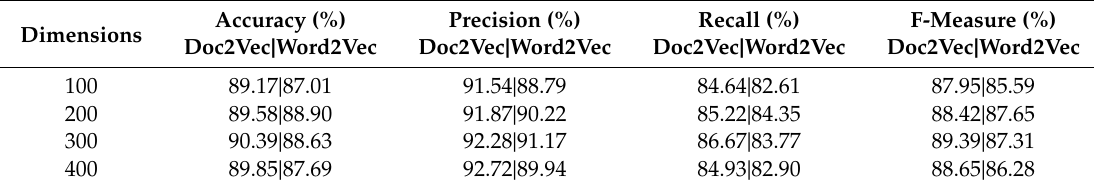
Table 5. Performance of Doc2Vec vs. Word2Vec on gambling website